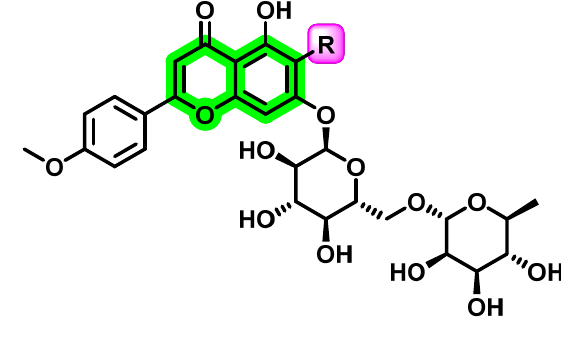
Figure 19. Structure of compounds extracted from Distictella elongata plant.